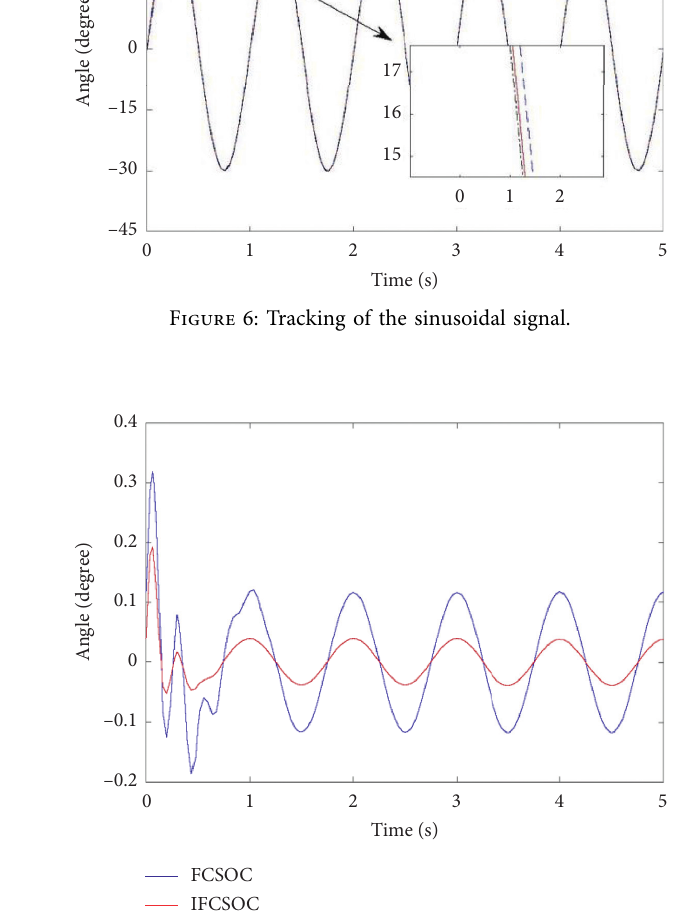
Figure 7: Tracking errors of the sinusoidal signal.